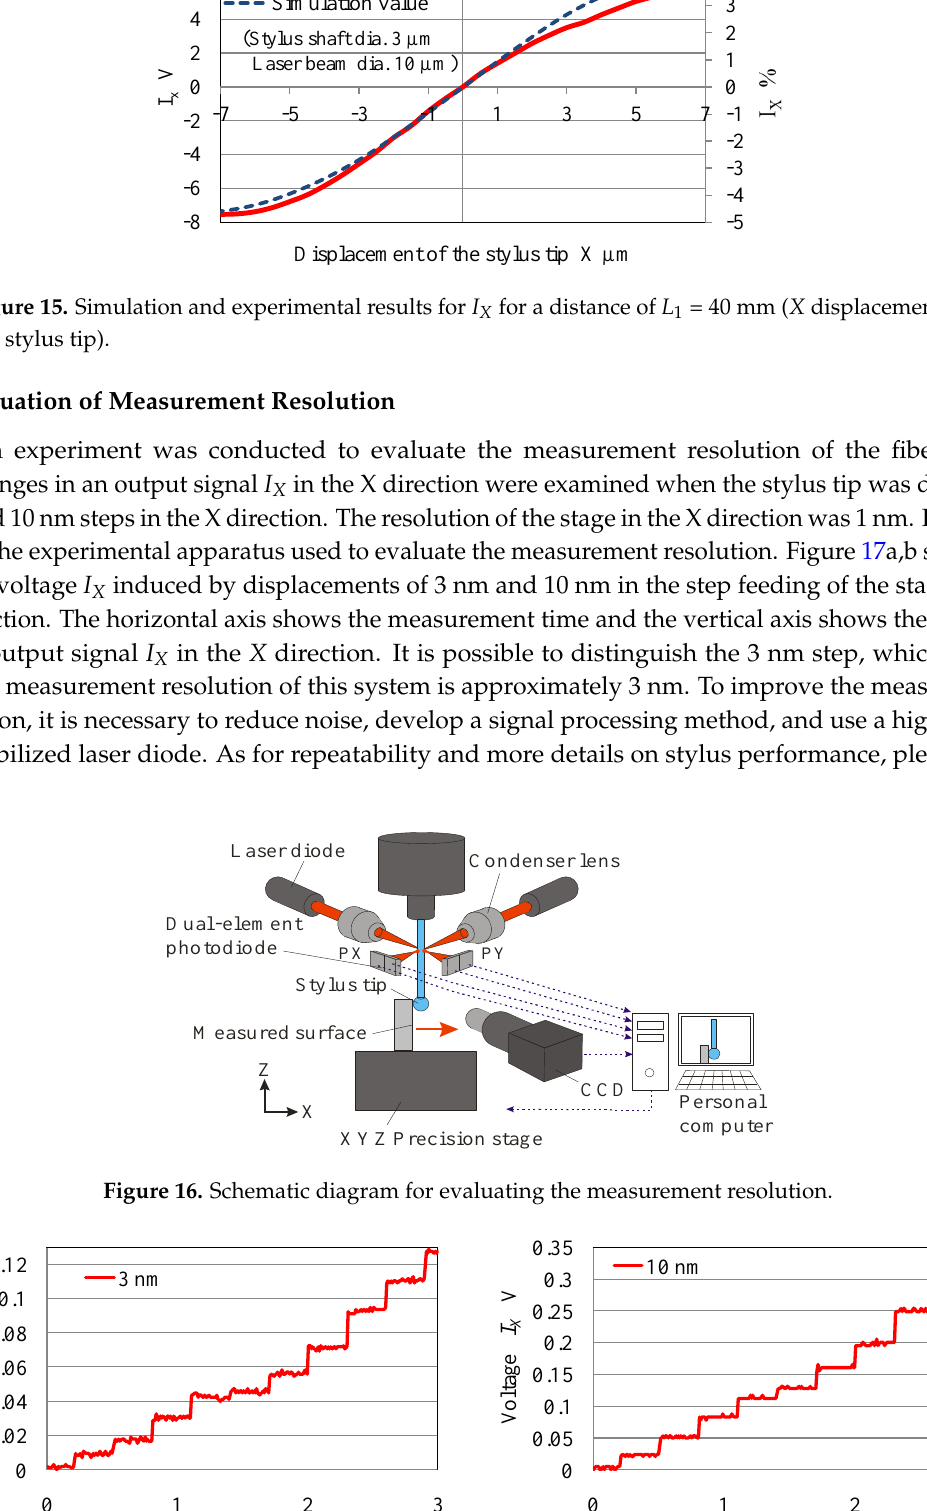
Figure 14. Simulation and experimental results for I Y for a distance of L 1 = 40 mm ( X displacement of the stylus tip).